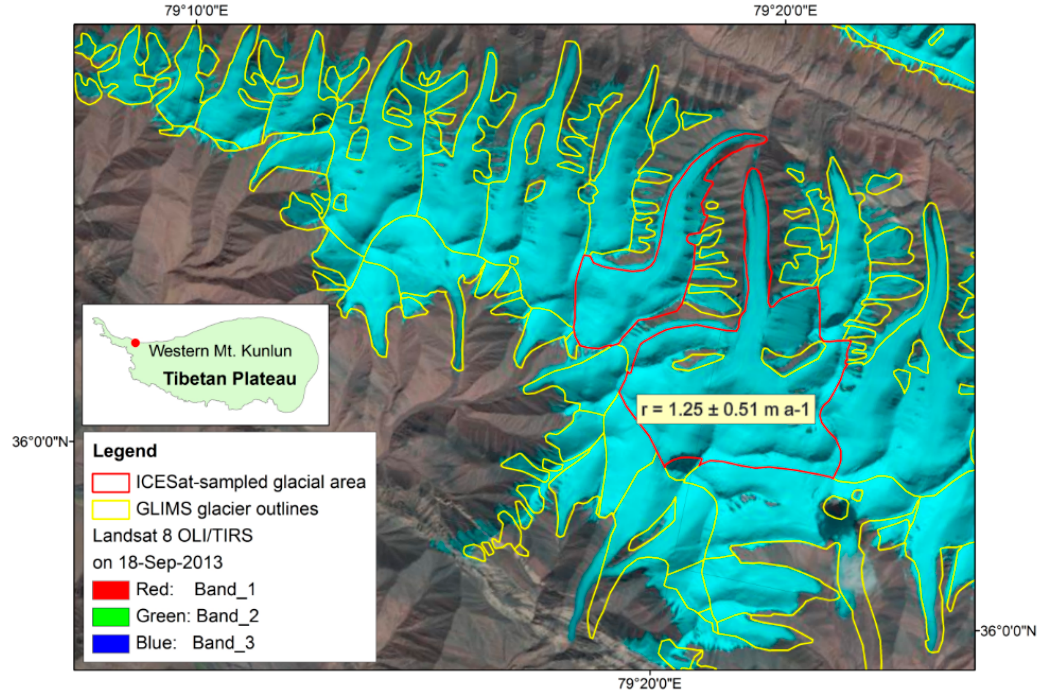
Figure 6. Strong glacial thickening between 2003 and 2009 at Western Kunlun Mountains The figure is created by overlaying the GLIMS glacier outlines on the Landsat 8 OLI/TIRS image from 18 September 2013.